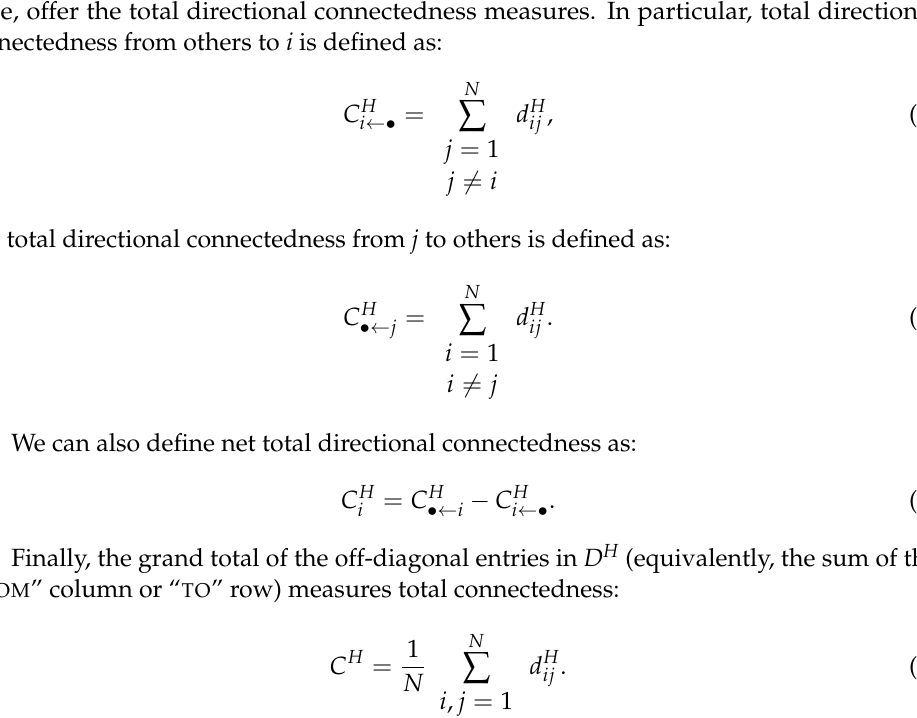
1 N 2 N . . . NN ∑ N d H i = 1 iN i (cid:54) = N